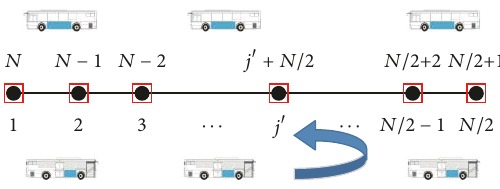
Figure 1: The dynamic short-turning